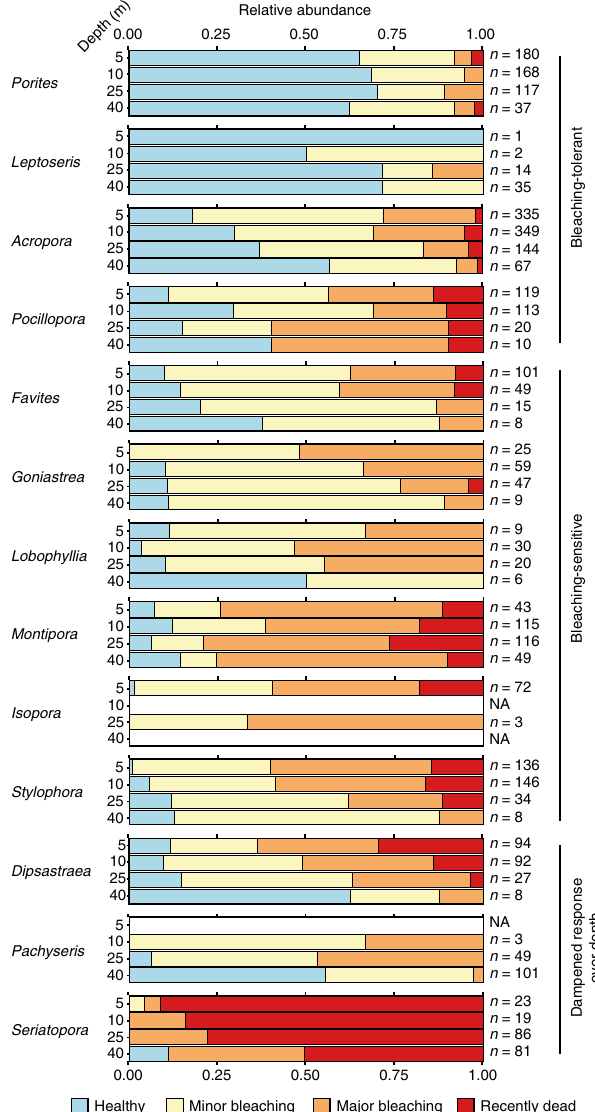
Fig. 4 Bleaching sensitivity over depth for the most abundant coral genera with all surveyed locations combined. Great Barrier Reef only. Stacked bar graphs give relative abundance of each bleaching category within each depth population. Note the occurrence of “ bleaching-tolerant ” taxa (i.e., Porites , Leptoseris , Acropora and Pocillopora ), “ bleaching-sensitive ” taxa (e.g., Stylophora, Isopora and Montipora ) and highly sensitive taxa to bleaching with “ dampened response over depth ” (i.e., Pachyseris , Dipsastraea and Seriatopora ), as sustained by our OLR bleaching model (see Fig. 5